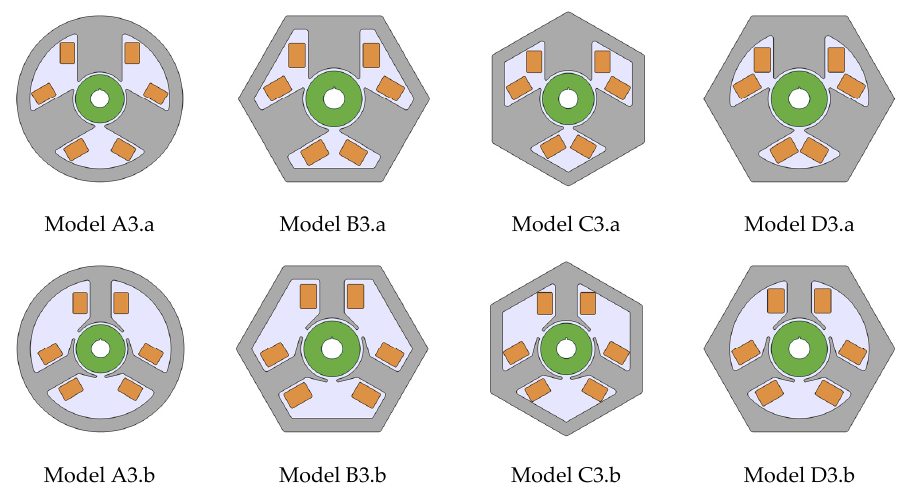
Figure 8. Analyzed configurations of the actuators/motors.